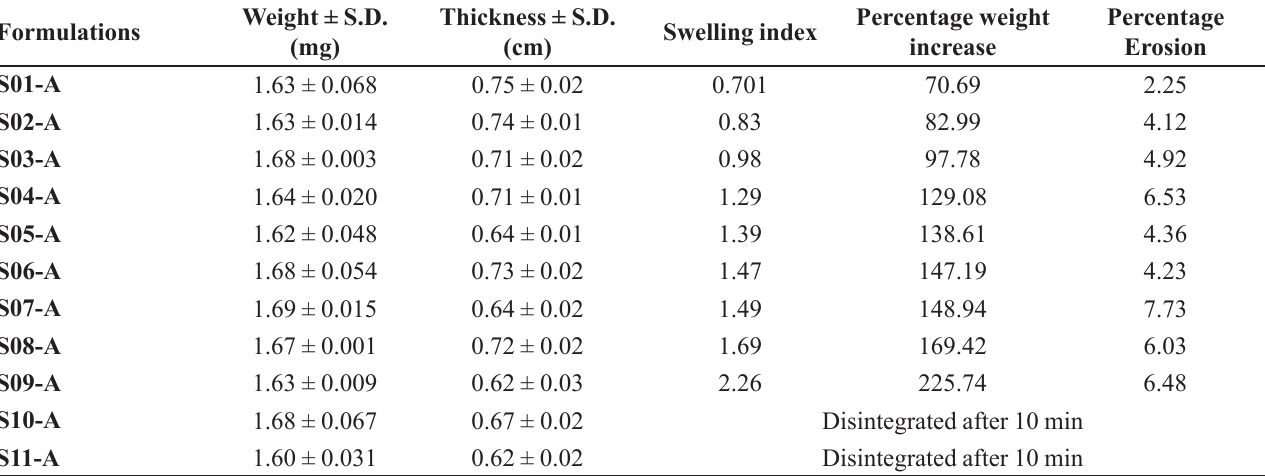
TABLE III - Results for weight variation, thickness, swelling index, percentage weight increase due to swelling and percentage erosion of transdermal patches of TZD HCl